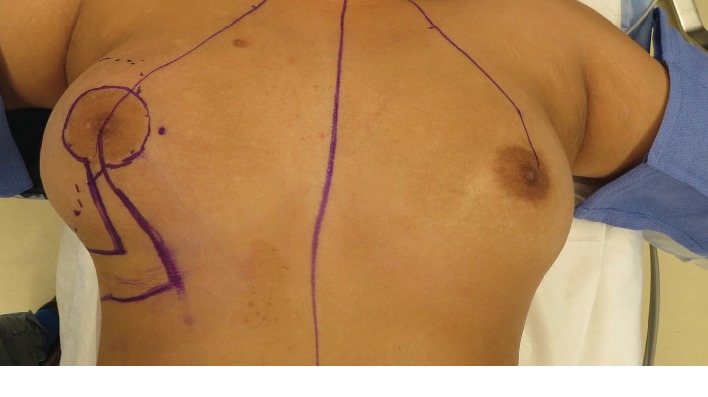
Preoperative image capturing prominence of tumor size and breast distortion relative to contralateral breast.